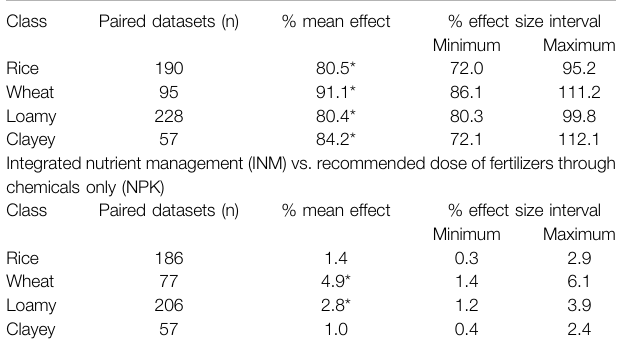
TABLE 1 | Effect of integrated nutrient management (INM) on crop performance with respect to without NPK and 100% NPK in rice and wheat crops as in fl uenced by soil texture: loamy and clayey in Indian